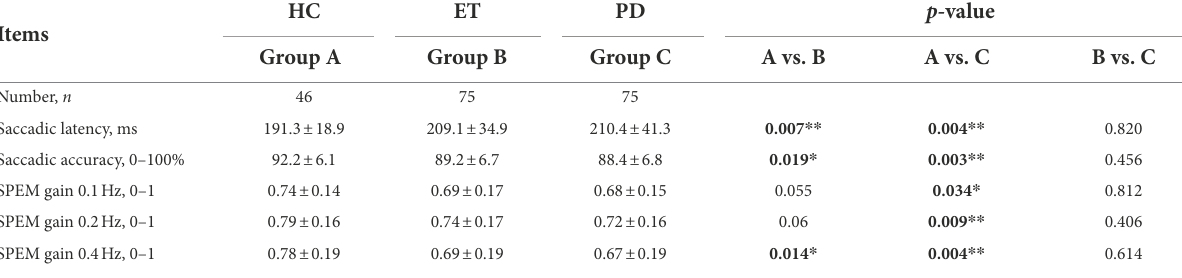
TABLE 2 Oculomotor characteristics in HCs, ET, and de novo PD patients.